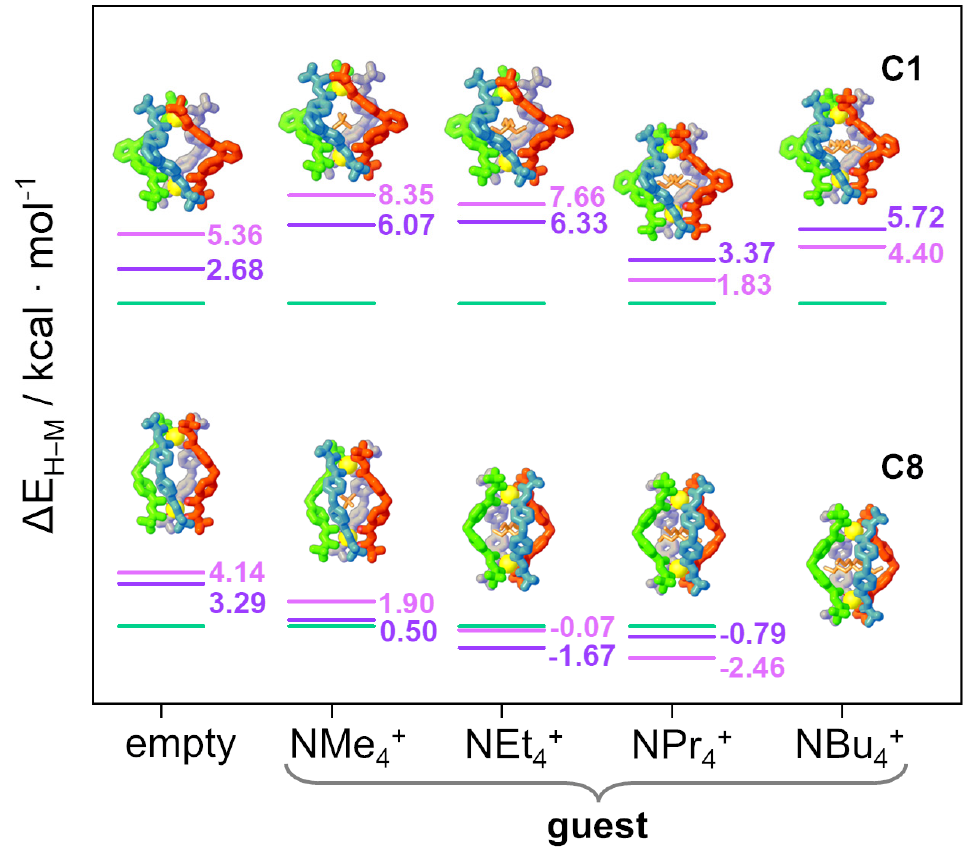
Figure 6. Energy differences Δ E H–M (kcal/mol) between helicate and mesocate isomers. Mesocate (violet in solvent and pink in vacuum calculations) and helicate (green). The energy of the helicate is chosen as 0. For the cage NBu 4 ⸦ C8 , the helicate did not converge, so Δ E H–M cannot be given.